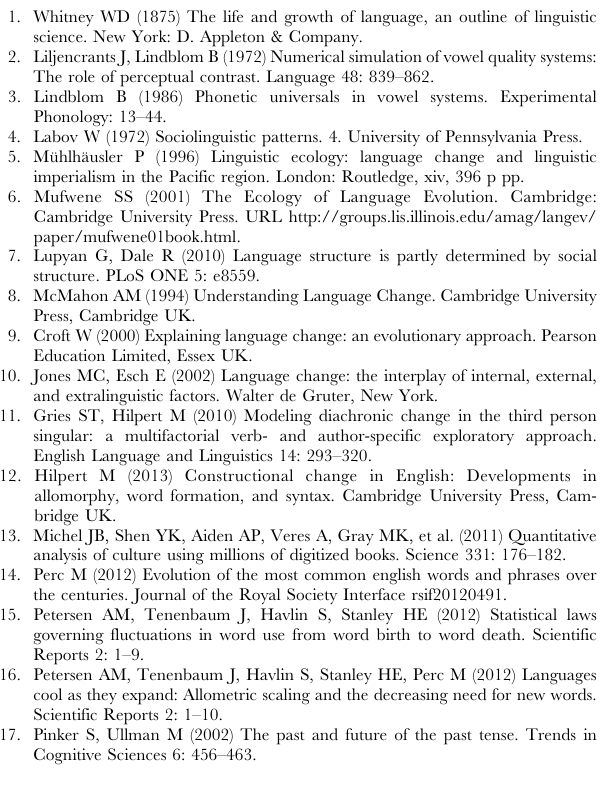
category. Figure S4 : Temporal trajectory of six transitioning roots. Figure S5 : Percentage of past tense tokens per decade which are irregular. Figure S6 : Variance over time of items in irregular phonlogical classes. Table S1 : Summary of verb token counts per decade prior to and after corpus preparation.